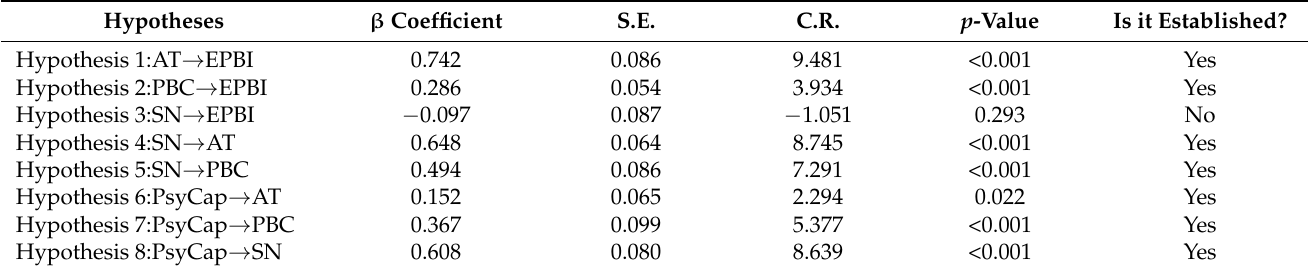
Table 5. Path coefficient estimation and hypothesis test of the